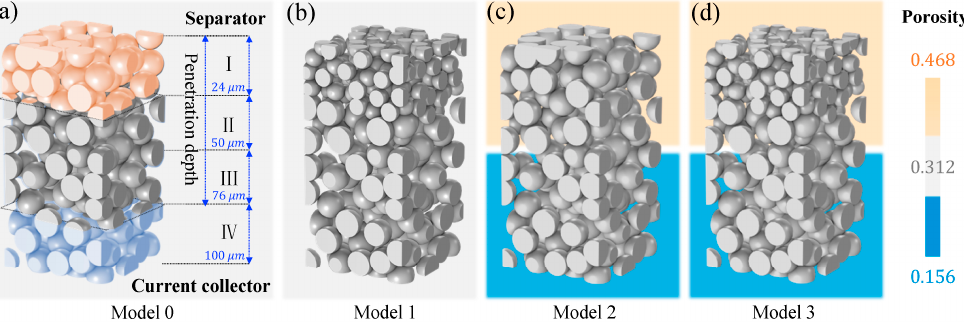
Figure 4. The regional graded electrode design. ( a ) Electrode region division strategies for homogeneous electrode; ( b ) a graded particle sizes electrode for improved SST capability; ( c ) a graded porosity electrode for improved LST capability; ( d ) a dual-gradient electrode incorporating graded particle size and porosity.